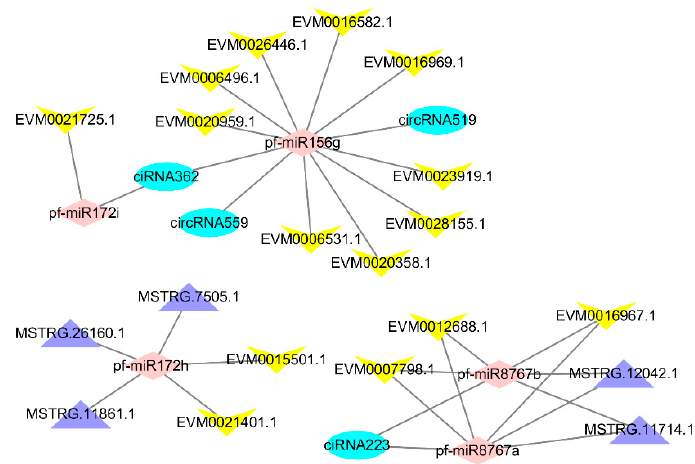
Figure 3. The Constructed ceRNA network. pink: miRNA, purple: lncRNA, blue: circRNA, yellow: mRNA.